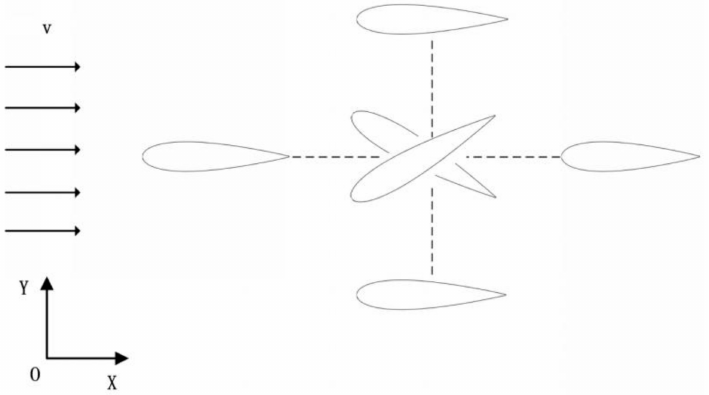
Figure 1. Three movement modes of flapping hydrofoil.